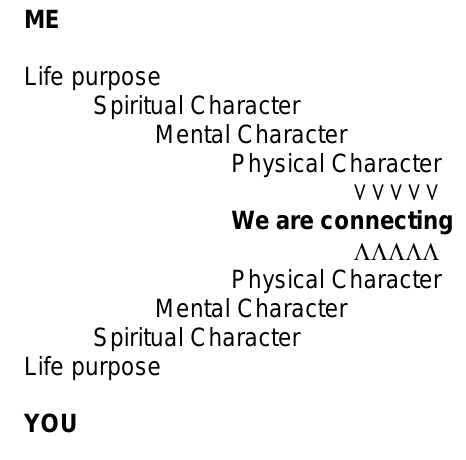
FIGURE 1. The purpose of life is manifested through the spiritual, mental, and physical character of the person and this character makes it possible for us to connect, communicate, and influence each